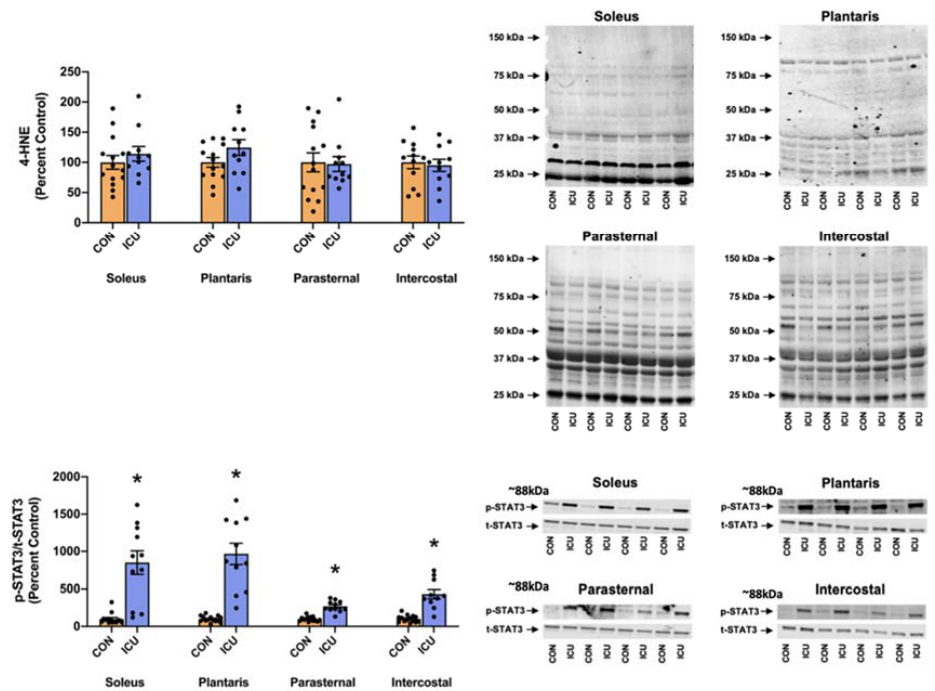
Figure 7. Stress signaling. 4-Hydroxynonenal (4-HNE) and p-STAT3/t-STAT3 (Tyr 705) in the soleus, plantaris, parasternal, and intercostal muscles of control, non-anesthetized, non-ventilated rats (CON), and rats that underwent 12 h of controlled mechanical ventilation (ICU). Representative Western blots are shown to the right of the graph. Data are presented as mean ± SEM. * significantly different vs. CON ( p < 0.05).